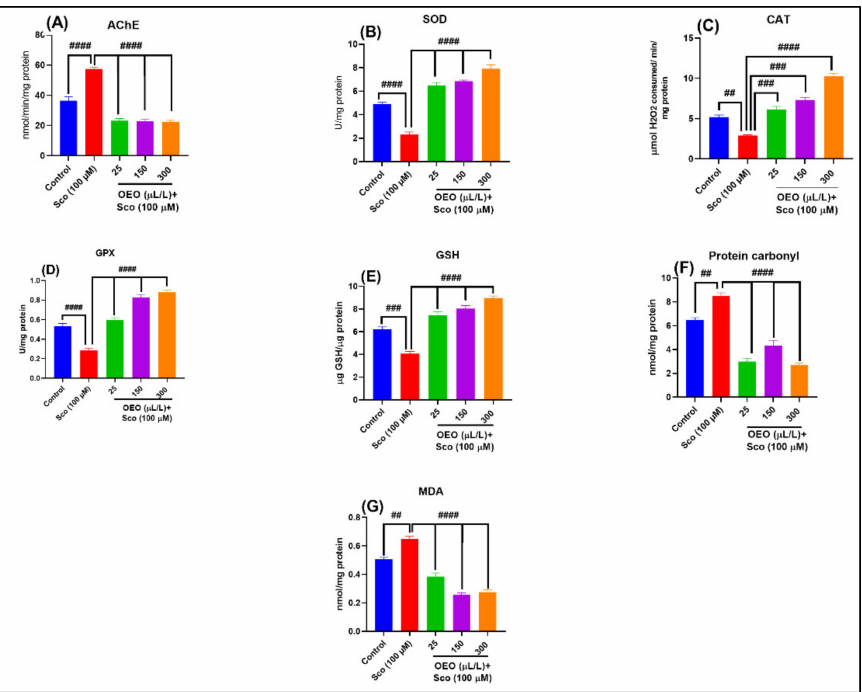
Figure 7. Antioxidant effects of Origanum vulgare ssp. hirtum essential oil (OEO: 25, 150, and 300 µ L/L) in scopolamine (Sco, 100 µ M)-induced memory impairment zebrafish brains: ( A ). acetylcholinesterase (AChE); ( B ). Superoxide dismutase (SOD); ( C ). Catalase (CAT); ( D ). Glutathione peroxidase (GPX); ( E ). Reduced glutathione; ( F ). Protein carbonyl; ( G ). Malondialdehyde (MDA). Values are means ± S.E.M. ( n = 10). For Tukey’s post hoc analyses: ## p < 0.001, ### p < 0.0001, and #### p <